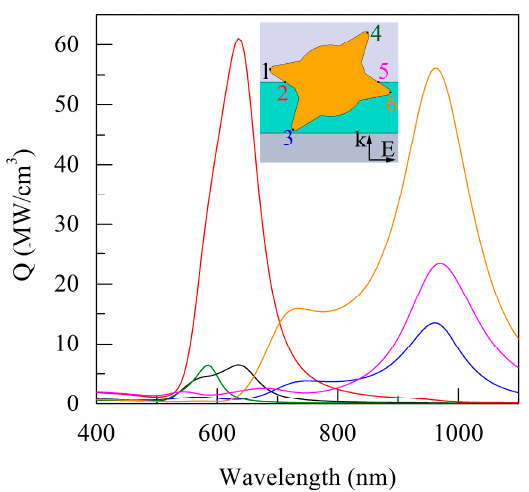
Figure 7. Spectral curves of the specific radiation absorption power Q at the indicated points on the GNS surface. The intensity of the irradiating field I 0 = 1 W/cm 2 . The designations of points and curves are the same as in Figure 6.